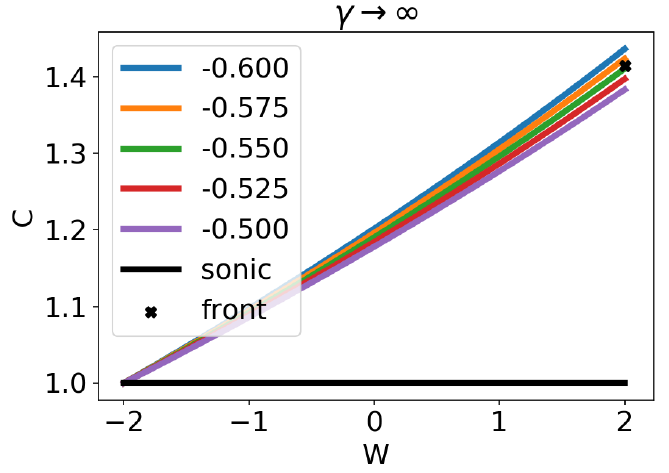
Figure 4. Hydrodynamic trajectories for the case γ → ∞ . Different coloured lined represent trajectories with different values of δ . The sonic line is represented by the black line, and the shock front by the black